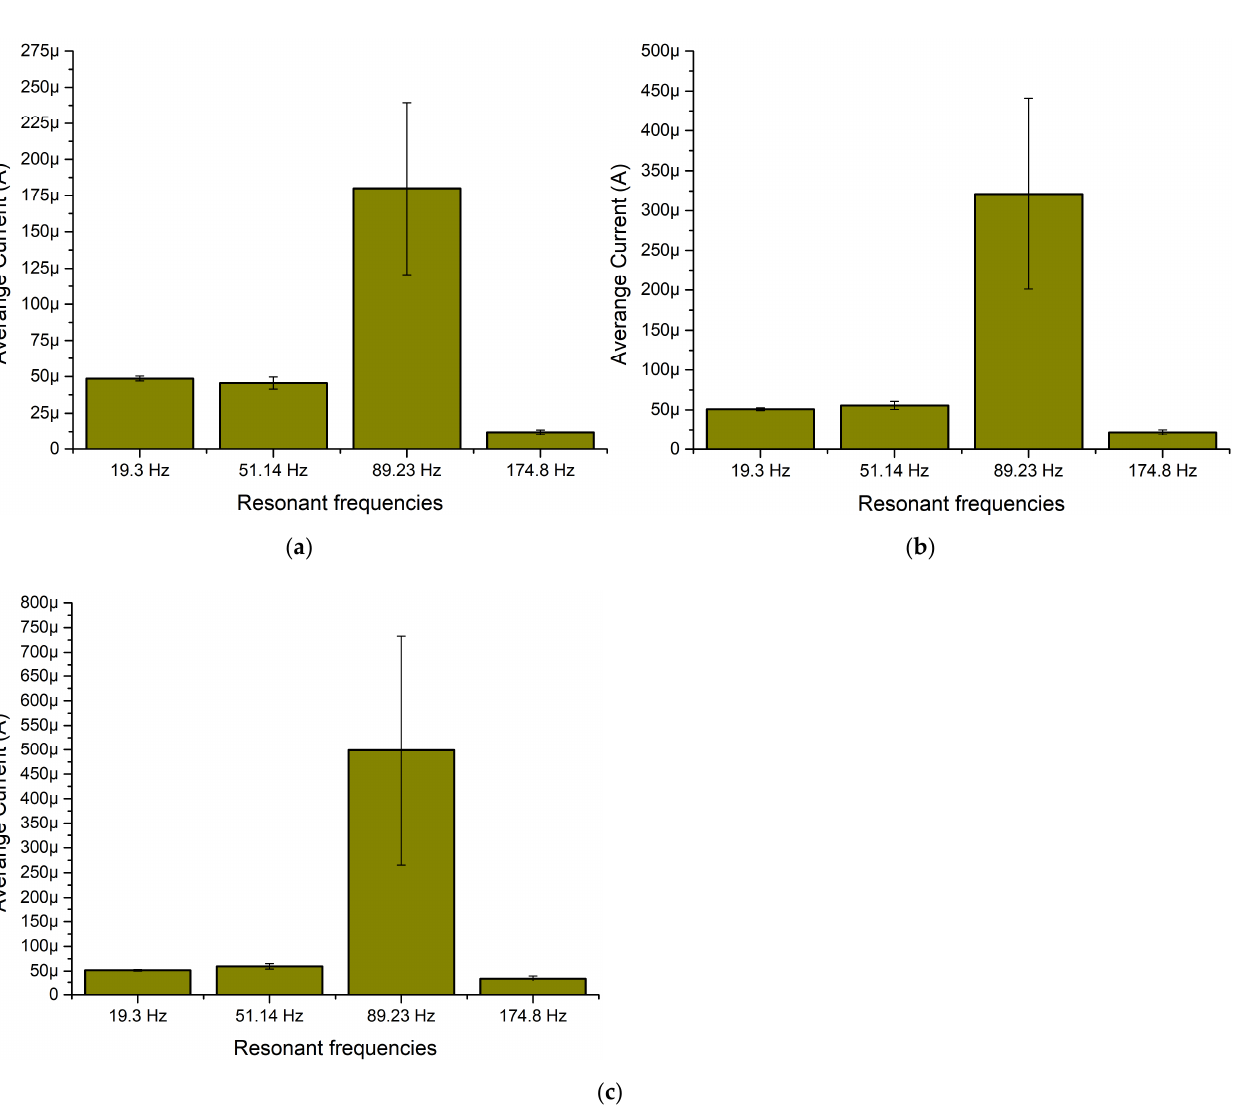
Figure 9. Summary of average output current at resonance frequencies while different loads are used; ( a )—load equal to 1 MΩ; ( b )—load equal to 500 kΩ; ( c )—load equal to 250 kΩ.